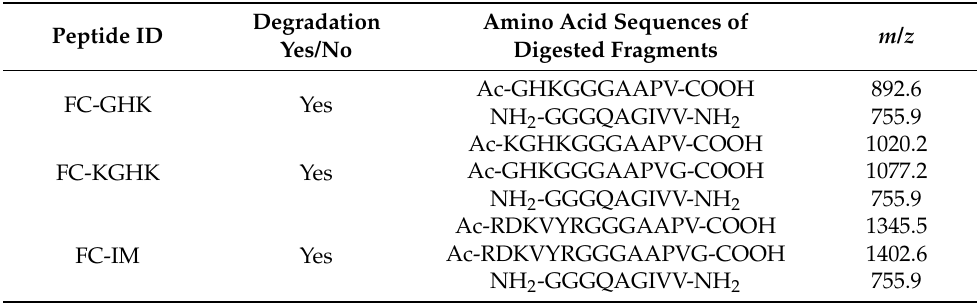
Table 2. The amino acid sequences and masses of the digested fragments for studied peptides after peptide degradation by human neutrophil